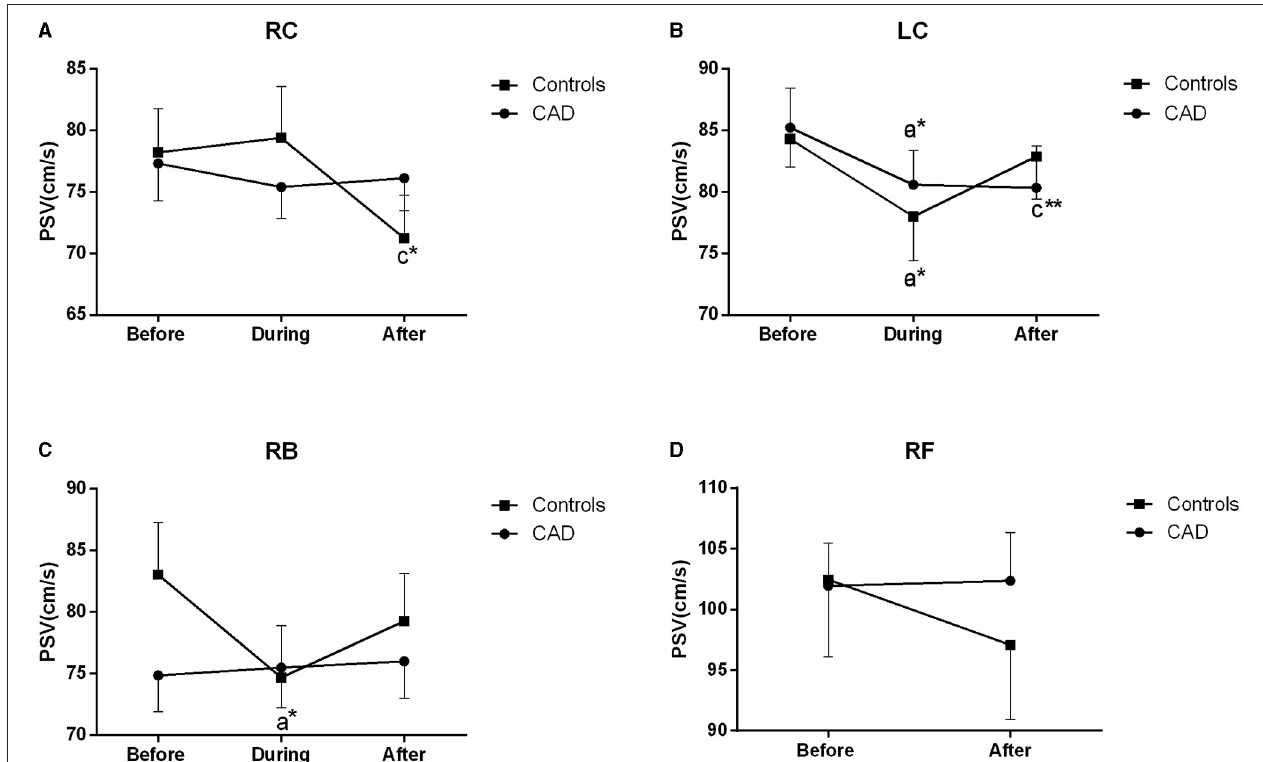
FIGURE 4 | Effect of EECP on the peak systolic velocity (PSV) of the RC and LC (A,B) , RB (C) , and RF (D) in the patients with CAD and controls before, during, and after a 45 min-EECP. a indicates significant differences in measurements obtained during EECPvs. pre-EECP; c refers to comparisons between post-EECP vs. pre-EECP. * and ** denote p < 0.5 and < 0.01 respectively.